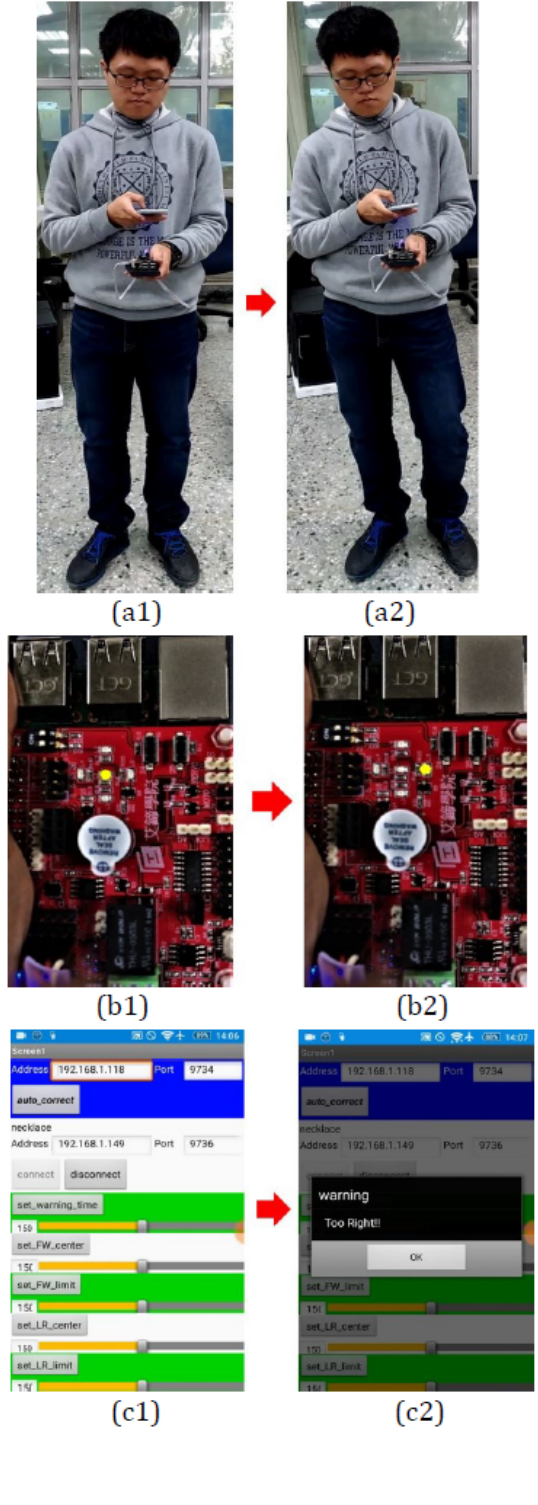
Figure 22. Posture with right